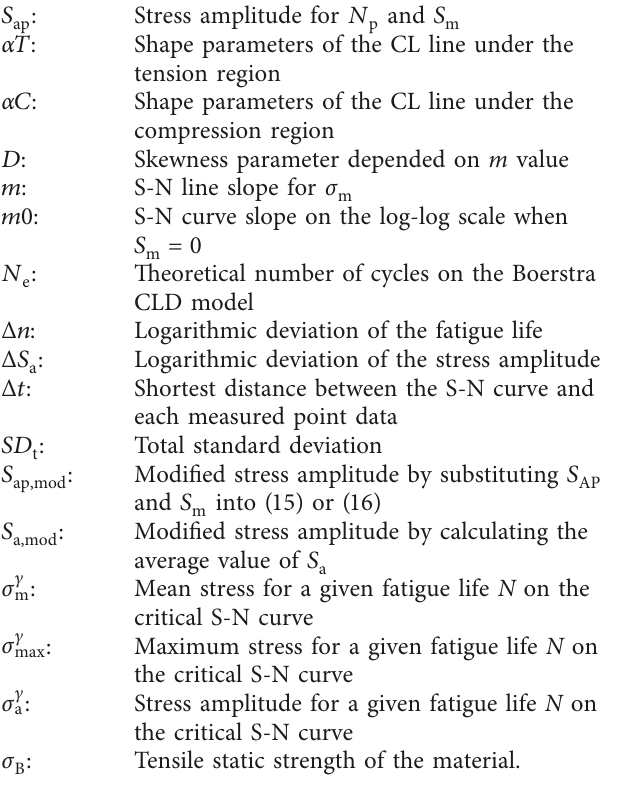
Supplementary Figure 1: fatigue test specimen of 2/1 laminates. Supplementary Figure 2: testing process and failure mode for 2/1 laminates. Supplementary Figure 3: fatigue test specimen of 3/2 laminates. Supplementary Figure 4: testing process and failure mode for 3/2 laminates. Supplementary Table 1: fatigue test data of 2/1 laminates and 3/2 laminates at different stress levels under different loading modes. ( Supplementary Materials